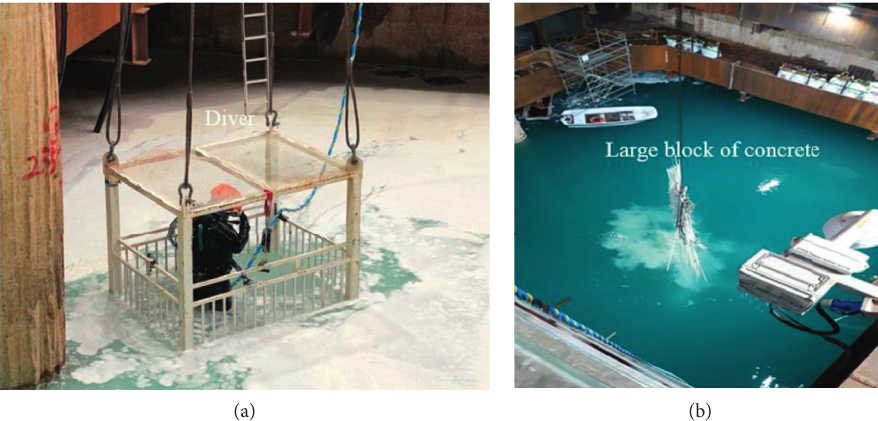
Figure 15: Removal of glass fiber-reinforced plastic and concrete: (a) using divers to cut off glass-fiber reinforced plastics and (b) using a crane to remove large blocks of